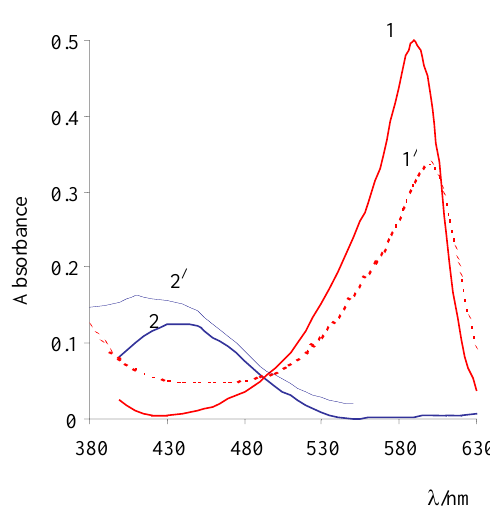
Figure 2. Absorption spectra of BP В species: R 2– , pH = 6 (1, 1 / ) and HR – , pH = 0–1.0 (2, 2 / ) (5.0 × 10